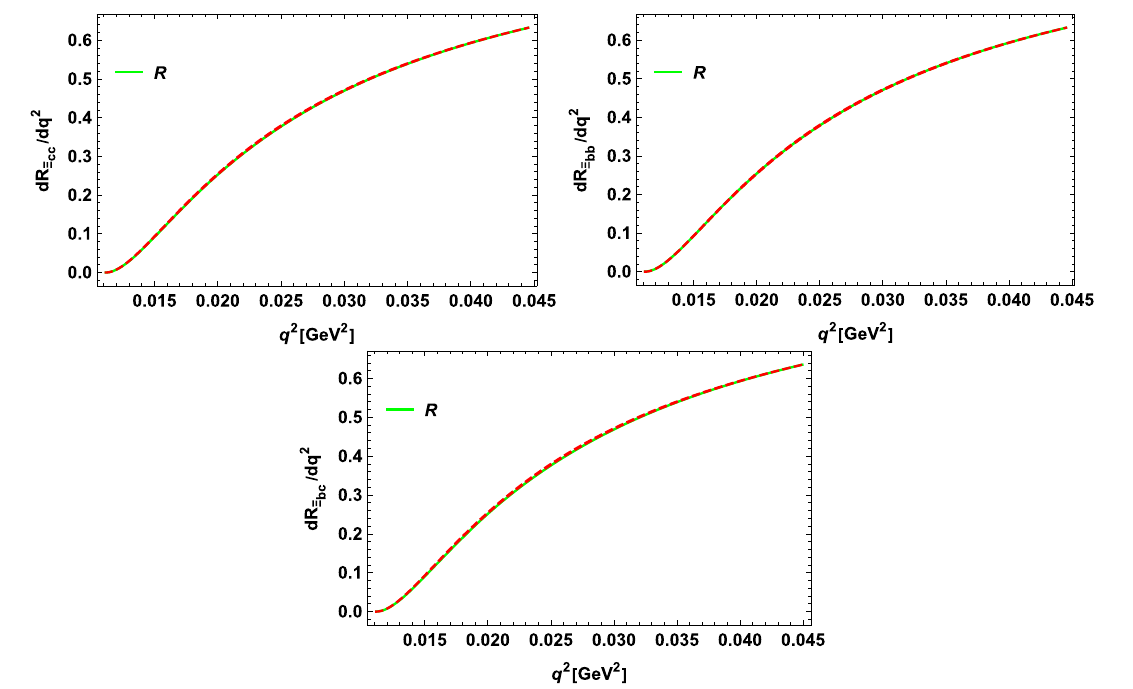
/ dq 2 of spin-3/2 to spin-1/2 doubly heavy baryon decay processes. The R represent the results from F( q 2 ) in Eq. (31) Fig. 6 The d R (cid:5) QQ The normalized forward–backward asymmetries of these pro- cesses are shown in Figs. 7 and